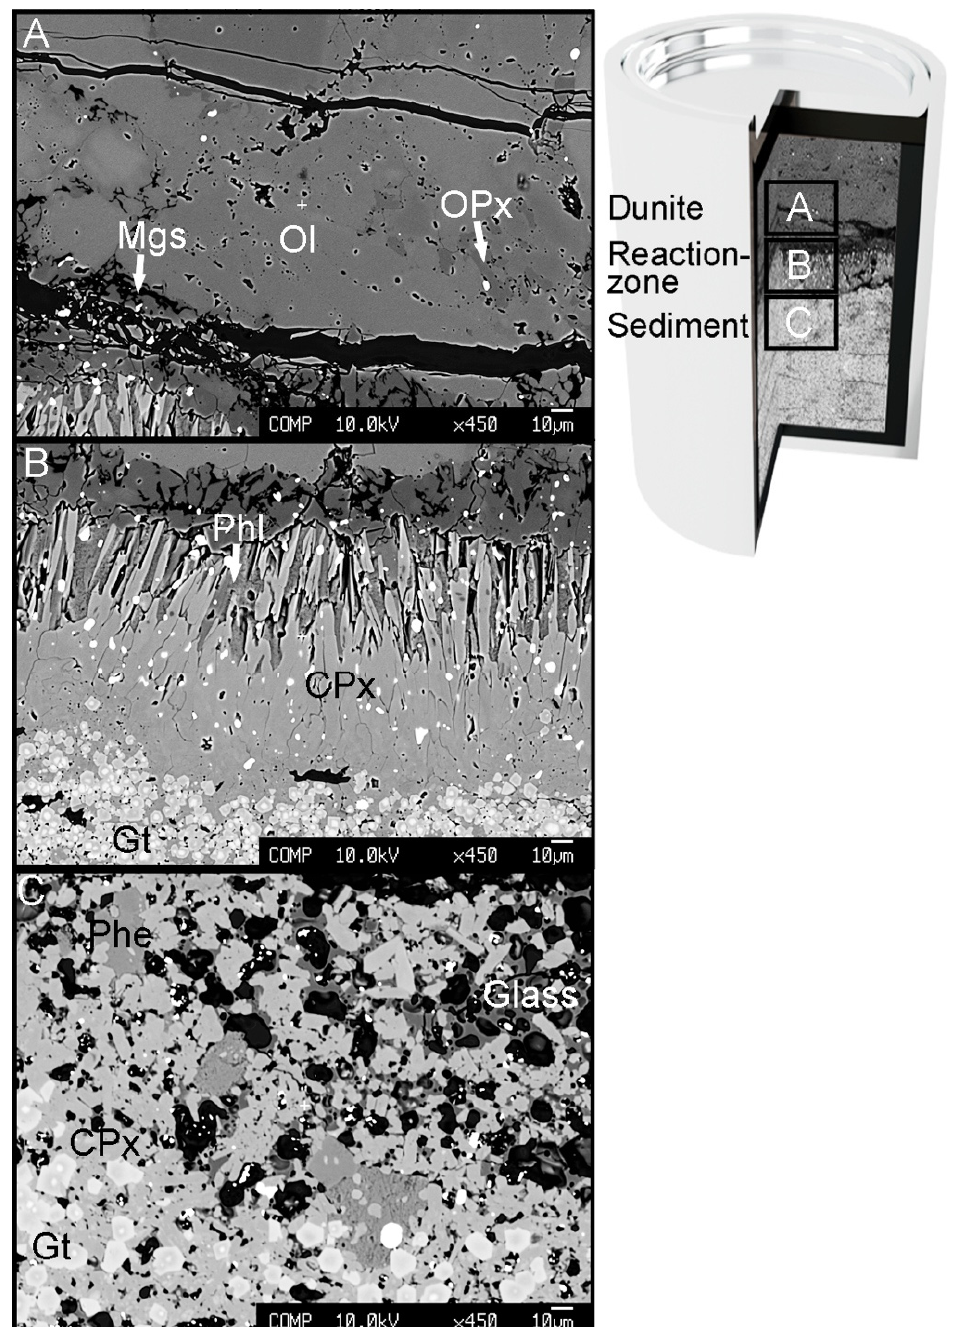
Figure A2. Phases present within the dunite ( A ), reaction zone ( B ), and sediment layer ( C ) of the 3 GPa/850 °C experiment. (Phases: Ol—olivine, Opx—Orthopyroxene, Cpx—Clinopyroxene, Gt—Garnet, Mgs—Magnesite, Phl—phlogopite, Phe—Phengite).